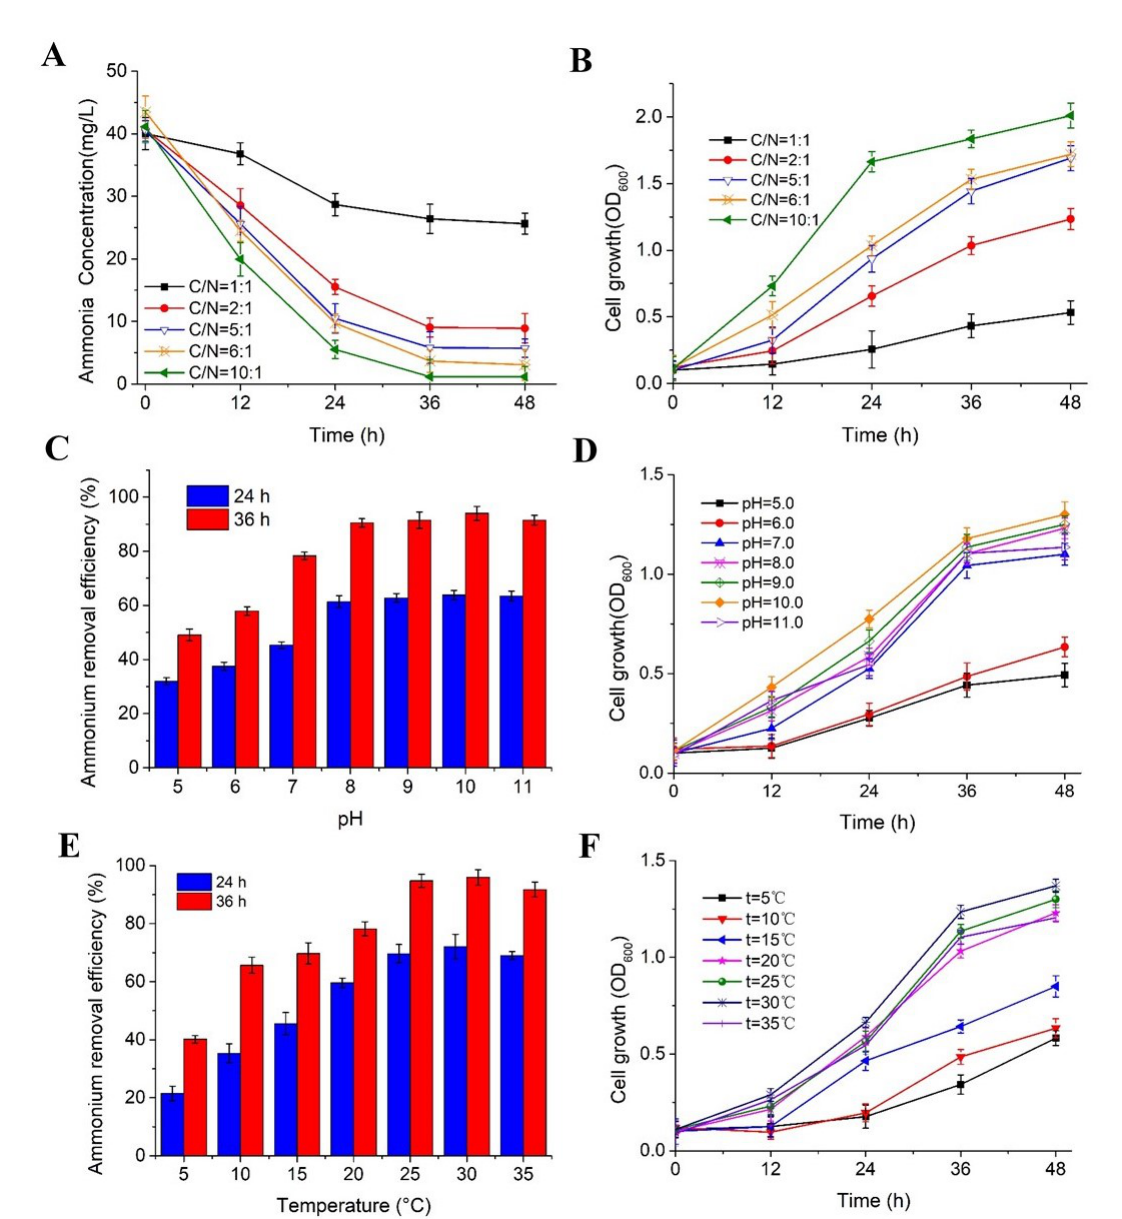
Figure 2. Analysis of factors a ff ecting the nitrogen removal capacity and cell growth of strain F19. ( A , B ) C / N ratio. ( C , D ) pH. ( E , F ) Temperature and